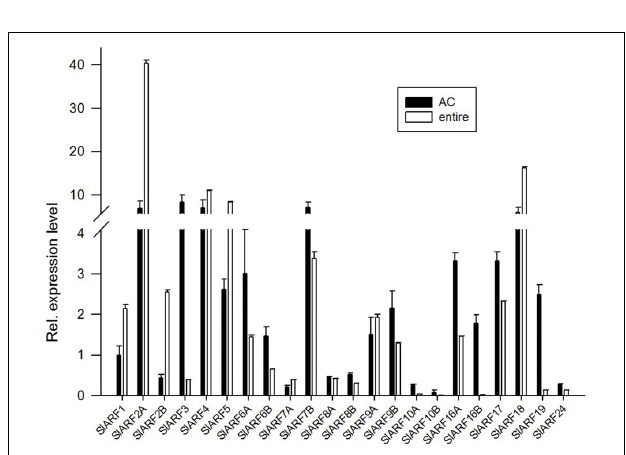
FIGURE 2 | The expression patterns of Multiple SlARFs were altered by e mutation. The expression of SlARF genes family in wild type (compound leaves material) and e mutant (simple leaves material) leaves. The relative expression was referred using the level of SlARF1 in the wild type control plant as calibrator. Standard errors (SE) are shown ( n =